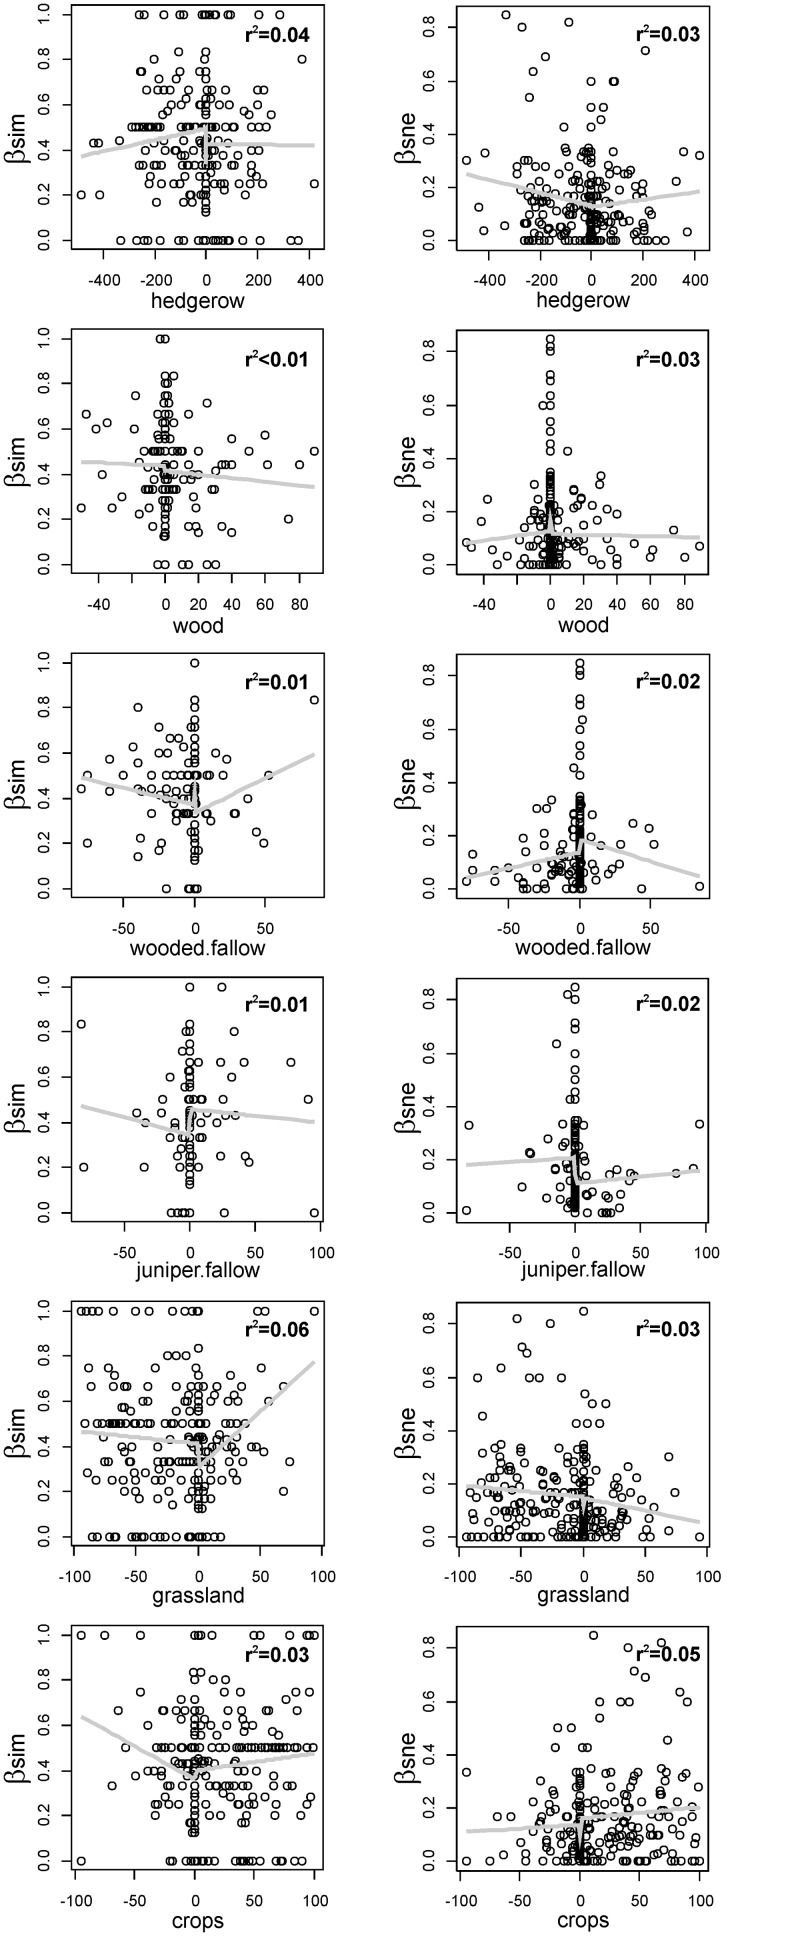
Relationship between temporal dissimilarity (turnover and nestedness-resultant components in the left and right column, respectively) and land cover change (by rows: temporal variation in hedgerow length, percentage of woodland area, wooded fallow area, juniper fallow area, permanent grassland area, crop area).Gray lines are the fitted functions from which r2 values were computed.